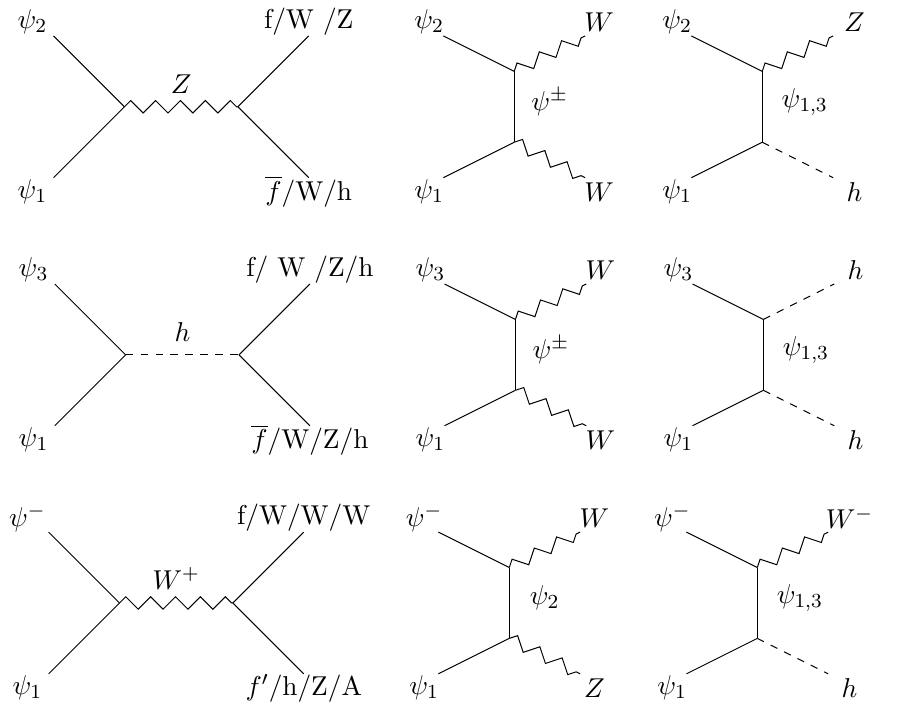
Figure 30. Feynman diagrams for DM co-annihilation to SM particles for the Fermion DM ( ψ 1 ) associated with the heavy states, ψ